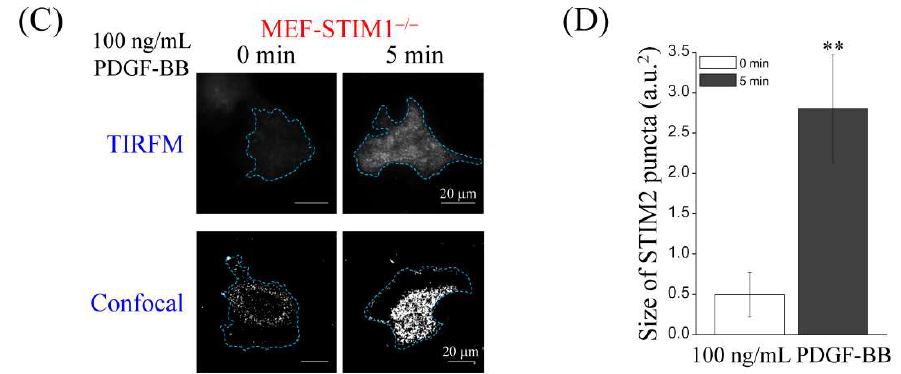
Figure 6. PDGF-BB induces STIM2 activation in MEF-STIM1 −/− cells. ( A ) MEF-WT (WT) and MEF-STIM1 −/− (STIM1 −/− ) cells were starved in a serum-free medium and then stimulated with 100 ng/mL PDGF-BB for 3, 5, and 10 min. Then, cells were processed for immunofluorescence staining using anti-STIM2 antibody, followed by adding a secondary antibody coupled to Alexa Fluor ® 488 dye. Fluorescence images were captured using a laser scanning confocal microscope. Yellow stars indicate cells with activated STIM2, presented as puncta formation and plasma membrane translocation. Scale bars = 20 μm; ( B ) Quantitative analysis of PDGF-BB-induced STIM2 activation that was assessed from the STIM2 plasma membrane translocated cells from three independent experiments. Bars represent mean ± SEM. *: p < 0.05; ***,###: p < 0.001 by Student’s t -test; ( C ) MEF-STIM1 −/− cells were starved in a serum-free medium and then stimulated with 100 ng/mL PDGF-BB for 5 min. Then, cells were processed for immunofluorescence staining using an anti-STIM2 antibody, followed by adding a secondary antibody coupled to Alexa Fluor ® 488 dye. Fluorescence images were captured using a total internal reflection fluorescence microscope or laser scanning confocal microscope. Blue dashed lines indicate the periphery of cells. Scale bars = 20 μm; ( D ) Quantitative analysis of PDGF-BB-induced aggregation of STIM2 puncta from three independent experiments ( n > 30 cells). Bars represent mean ± SEM. **: p < 0.01 by Student’s t -test.